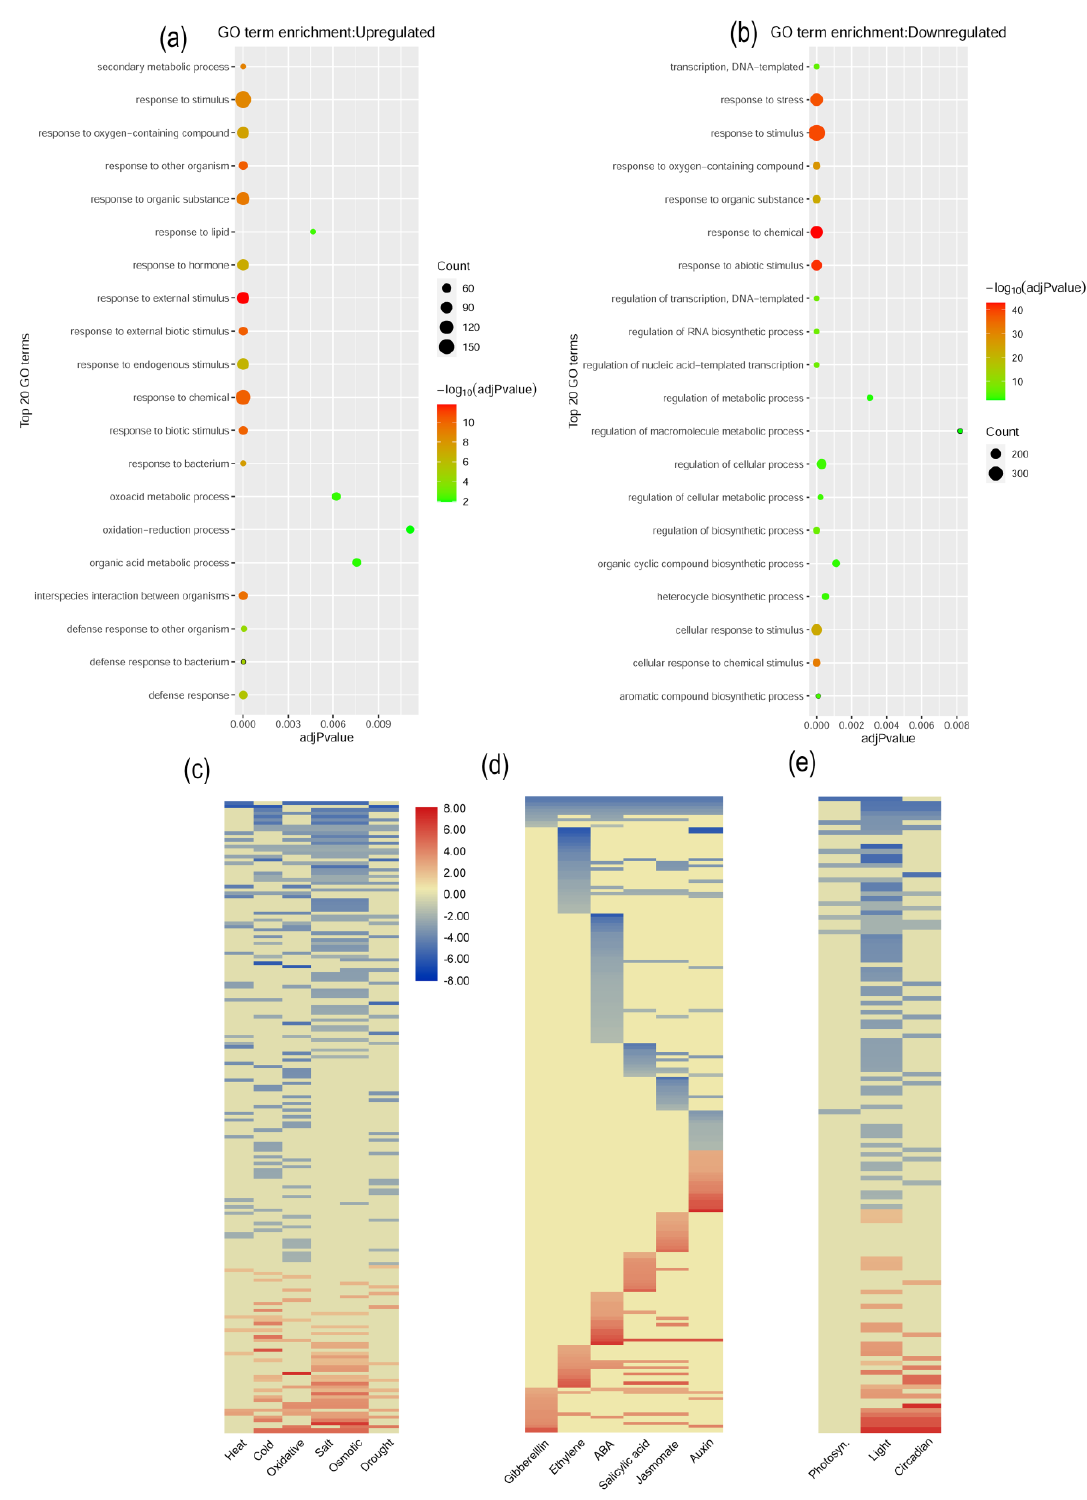
Figure 4. Functional enrichment and classification of differentially expressed genes of thermo-tolerant BrPP5.2OX transgenic lines. ( a , b ) Statistical enrichment analysis of corresponding gene ontologies of significantly (logFC ≥ 2; FDR < 0.05) upregulated ( a ) (652 DEGs) and ( b ) downregulated (864 DEGs) genes reported in thermotolerant transgenic lines by the gProfiler tool. ( c – e ) Heat maps represent the expression pattern of predominant DEGs responsible for abiotic stress responses ( c ) (heat, cold, oxidative, salt, osmotic, and drought stress), hormonal responses ( d ) (gibberellins, ethylene, salicylic acid, jasmonate, and auxin), ( e ) photosynthesis, light stimulus response, and circadian genes of transgenic